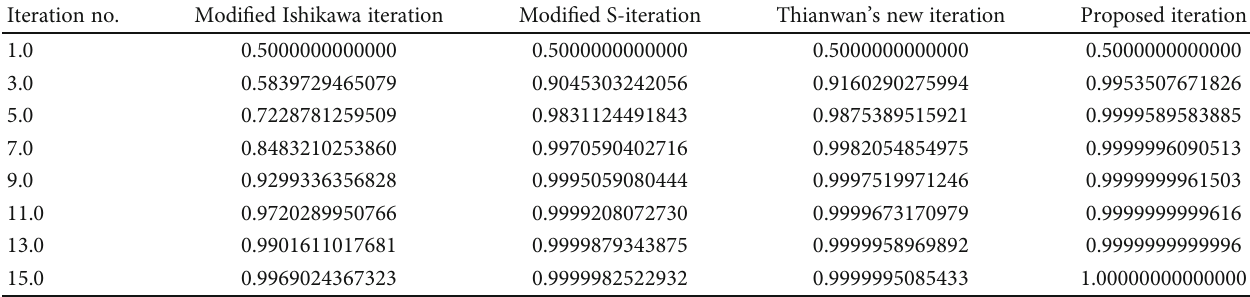
Table 1: Convergence of iterative schemes.